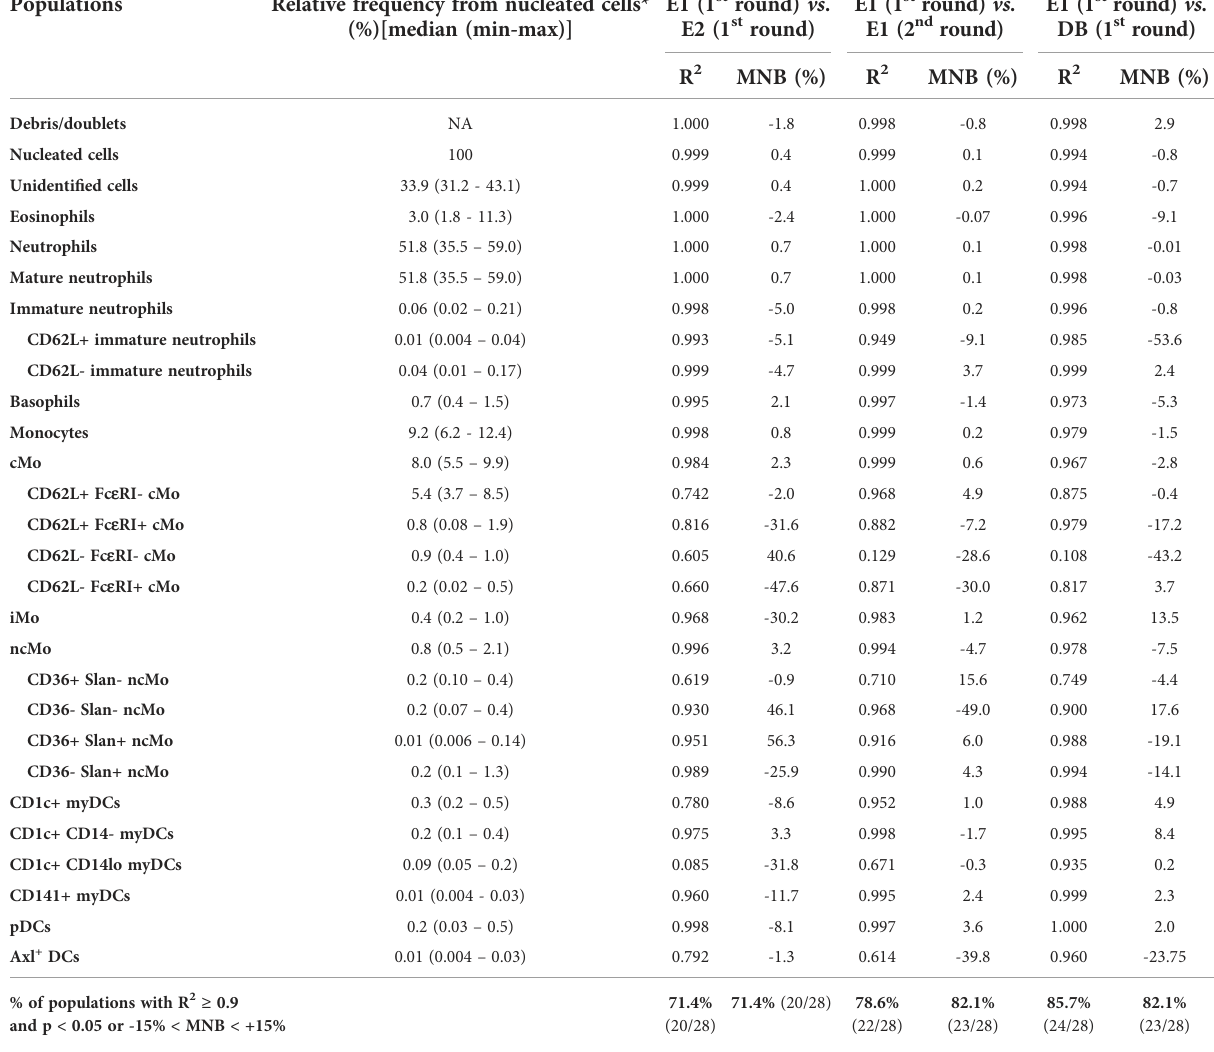
TABLE 3 Reproducibility of manual analysis and automated database-guided analysis for the identi fi cation of all innate myeloid cell (IMC) and non-IMC populations (n=28) in EDTA-anticoagulated peripheral blood samples (n=6) stained with version 3 of the EuroFlow IMC tube.